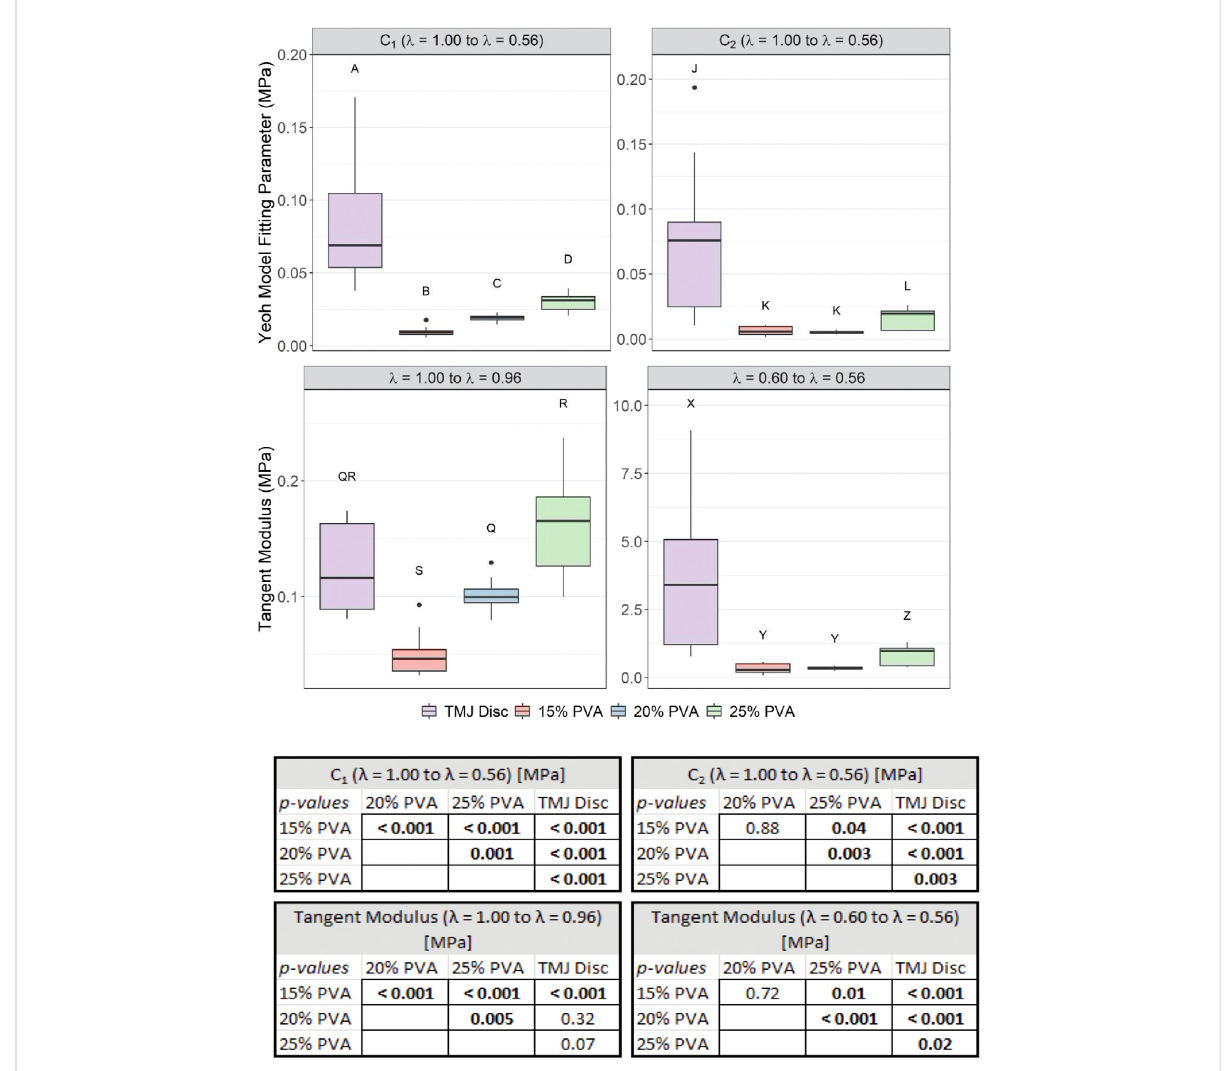
Box-and-whiskerplotsofthecalculated2-term Yeohmodel fi ttingparameters (C1,C2) fromA=1.00to A=0.56,andthetangentmoduli from A = 1.00 to A = 0.96 and from A = 0.60 to A = 0.56. Groups that do not share a letter were signi fi cantly different. All p -values for post hoc Wilcoxon rank-sum comparisons are provided in the associated table